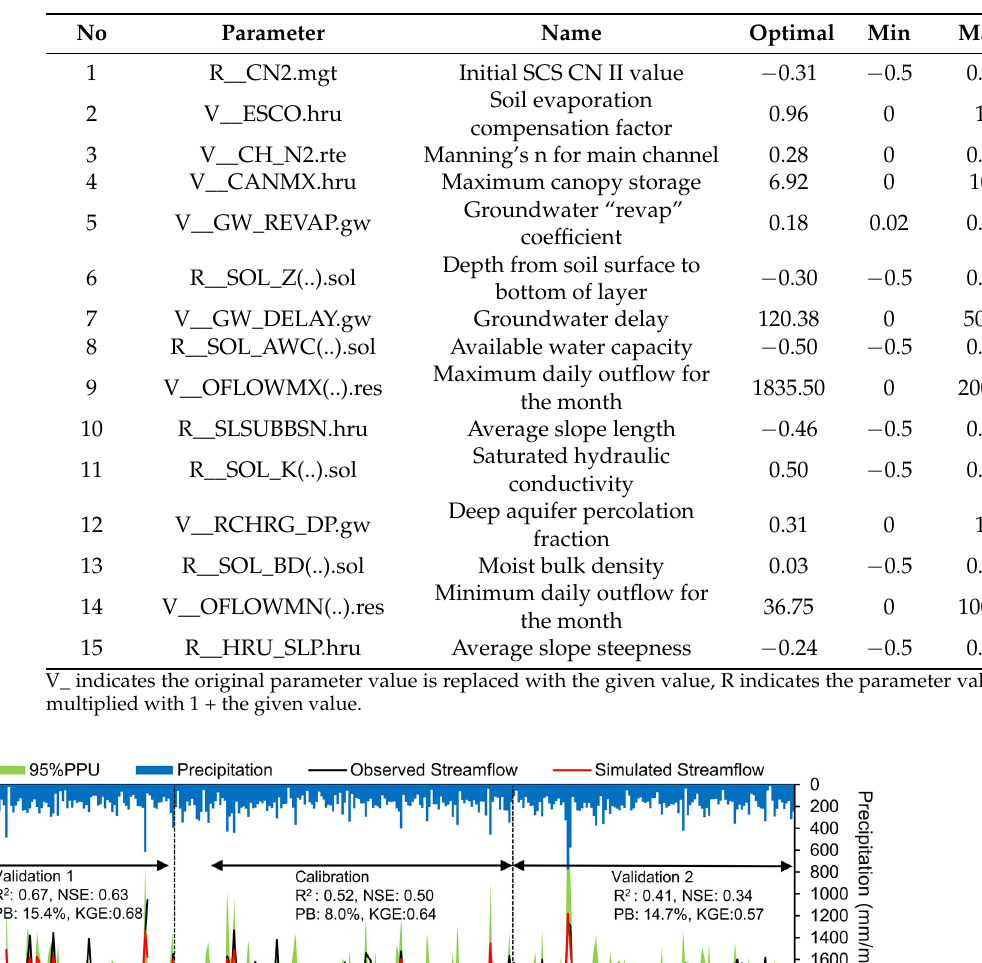
Table 3. Calibrated SWAT parameters for the Johor River Basin.